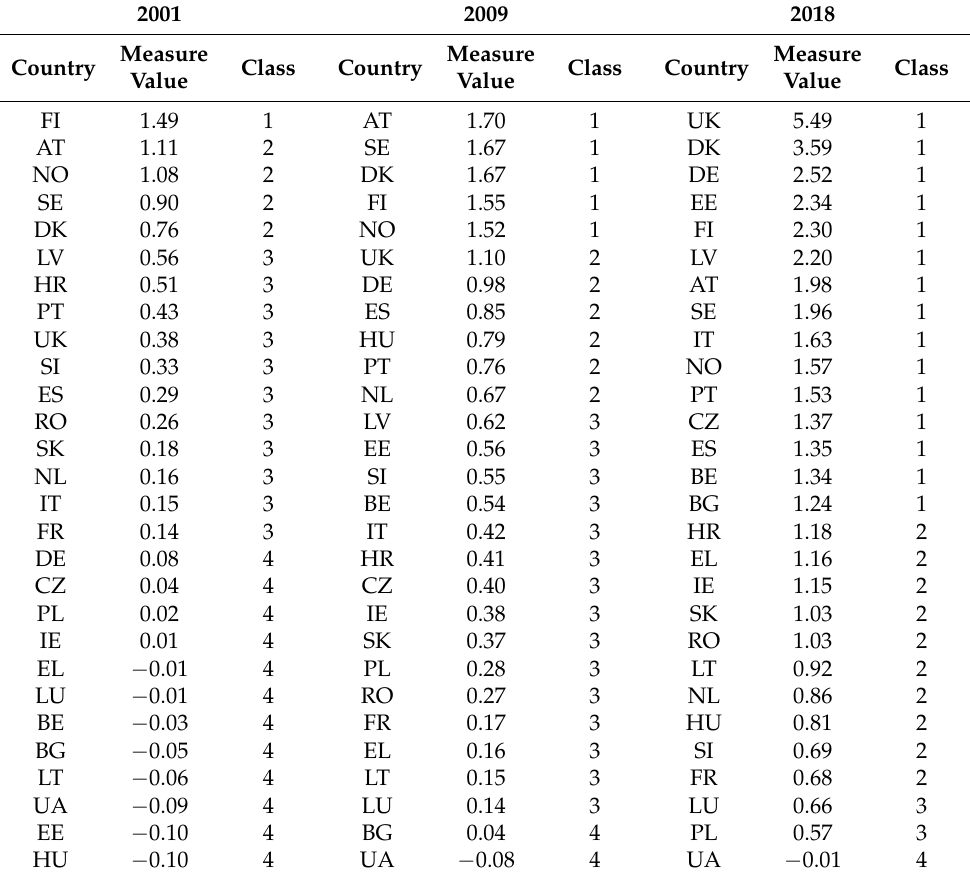
Table 4. Ranking of selected European countries in 2001, 2009 and 2018 (VMCM) with respect to the 2009 artificial